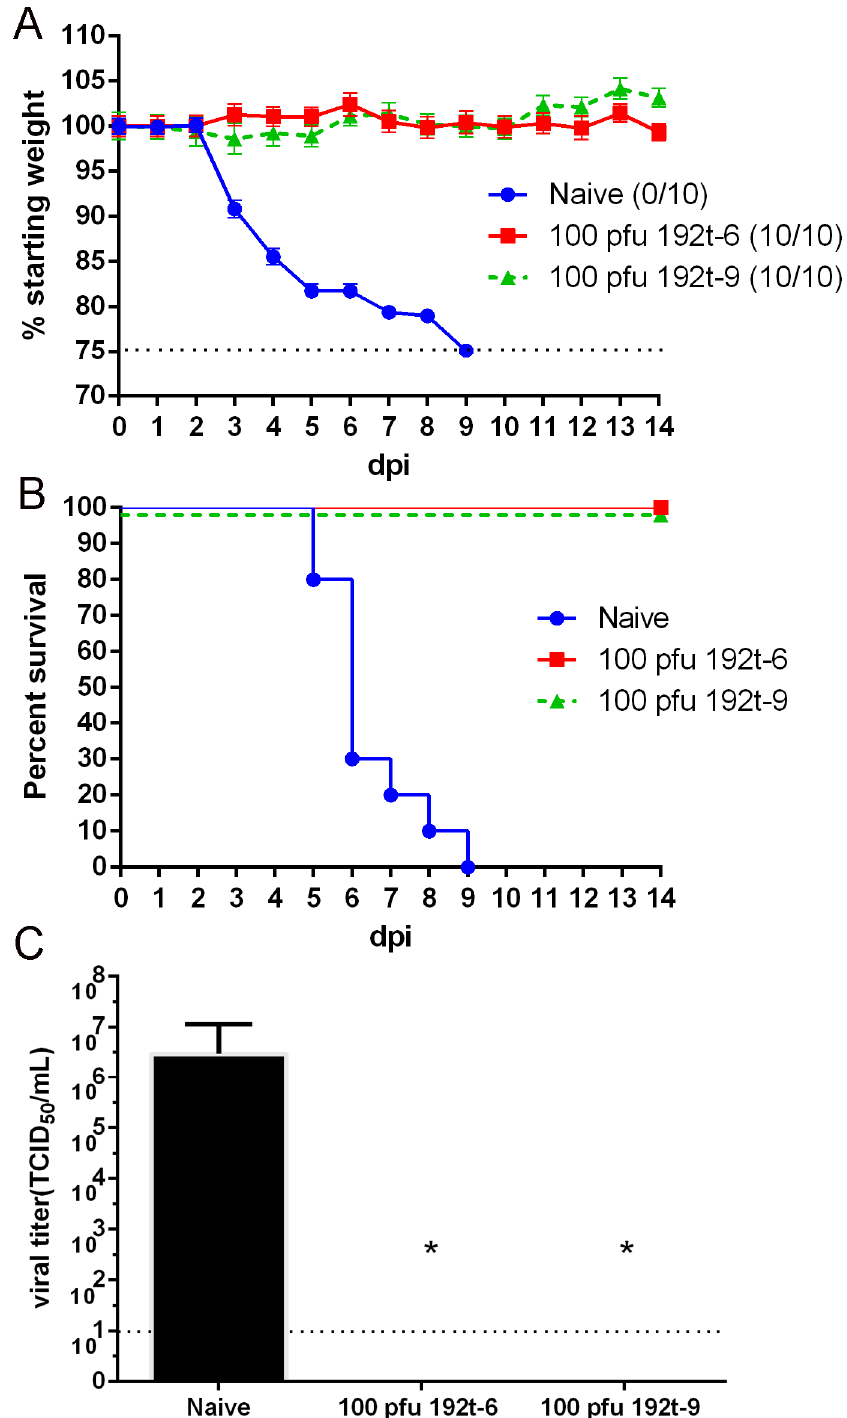
Figure 6. miRNA targeted viruses of 192t-6 and 192t-9 provide protection against heterosubtypic virus challenge. Mice were immunized i.n. once with 192t-6, 192t-9 and naïve, and challenged with a lethal dose of 5 × LD 50 H3N2 influenza virus four weeks after immunization. Bodyweight changes ( A ) and survival rates ( B ) of mice were measured daily for two weeks after challenge. ( C ) Mice in each group were detected at three days after the challenge by TCID 50 assay. Data shown as mean ± SD. n = 5 per group. Each sample was tested in triplicates. Dotted line represents limit of detection. * p < 0.05, compared to the naive group.